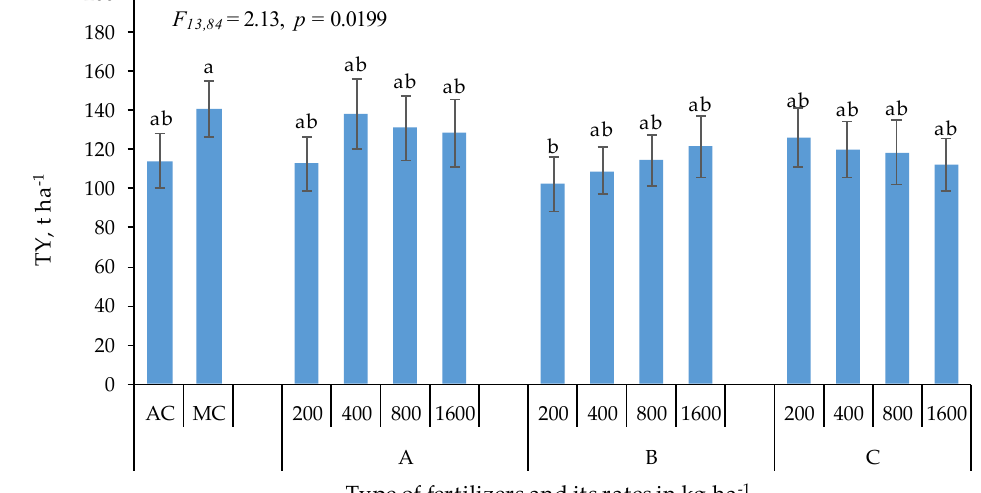
Figure 1. Effect of bio-fertilizer application on total yield (TY) of tomato (mean for 2016–2018). Letters indicate significant differences between treatments ( p < 0.05). Hatched bars represent 2 × standard error ( SE ) ranges. Key: A, B and C—bio-fertilizers; AC—absolute control; MC—mineral control. A net increase, compared to the AC plot, and the plot with 200 kg ha −1 (A200), was 21.0%, and 22.7%, respectively. Fertilizer rates greater than 400 kg ha −1 resulted in an av- erage tomato yield decrease by 5.3–7.2%. In plots fertilized with B fertilizer, the fruit yield increased progressively with the increasing fertilizer rate. The difference between plots fertilized with 200 and 1600 kg ha −1 was only 18%. It is necessary to stress that TY on plots with 200 and 400 kg ha −1 of applied fertilizer yielded less than that recorded on the AC plot. Plants fertilized with the C fertilizer yielded the highest on the C200 plot. Any higher rate of applied fertilizer resulted in a progressive yield reduction. The yield decrease, as recorded on the plot fertilized with 1600 kg ha −1 , reached 12%. The commercial yield (CY) of tomato fruits in the study years contributed to 77.8%, 72.2%, and 62.3% of the TY, respectively in 2016, 2017, and 2018. The lower percentage share of the total commercial yield in 2018 resulted in a significant difference between 2016 and 2018 (Table S2), unlike the TY. There was no significant effect of the tested ferti- lizers on the marketable fruit yield. No significant interaction between the growing season and the fertilization treatments on the CY was found in the experiment. In 2016, the high- est yield was obtained on the MC plot, and in 2017, 2018 on the A400 plot (Table S3). However, clear trends and differences were observed in the level of yields be- tween individual treatments. Also, the value of the “ p ” statistic was close to the conven- tional critical value of 0.05. The relationships between the experimental treatments were very similar to those recorded for the TY (Figure 2 vs. Figure 1). The best yield-forming effect of the A bio-fertilizer was recorded on the plot treated with 400 kg ha −1 . It is also worth noting that, unlike TY, the average CY in the A400 variant was higher than that recorded in the MC plot. The difference was 6.5% (100.8 versus 94.7 t ha −1 ). The increase in yield in this variant as compared to the AC was much higher, amounting to 27.7%. The tomato also yielded well on plot C, treated with 200 kg ha −1 . Compared to AC, the yield increase in the C200 variant was 15.9%. However, any further rate of this fertilizer increase resulted in a progressive yield decline. A reverse trend was observed on the main plot fertilized with the B bio-fertilizer. The lowest rates of this fertilizer resulted in a yield de- pression as compared to AC. The relative drop for B200 was 6%. The yield gap was not overcome until the application of 800 kg ha −1 of this fertilizer.